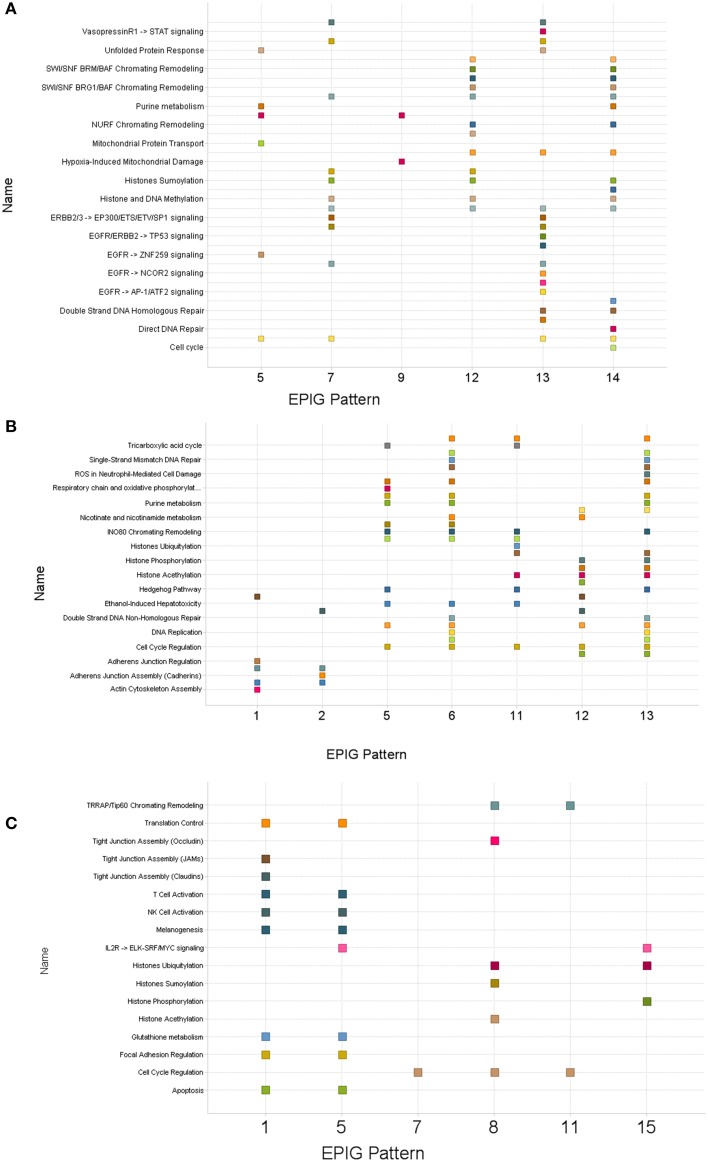
Scatter plots of pathways enriched in patterns derived from bone marrow collected post-treatment with topotecan, oxaliplatin, or a combination. Clusters of genes identified by EPIG were then analyzed using Gene Set Enrichment Analysis (GSEA) and Sub-Network Enrichment Analysis (SNEA) algorithms to find enriched pathways. (A) One hour post-treatment. (B) Six hours post-treatment. (C) Twenty-four hours post-treatment. The numbers on the x-axis denote the EPIG pattern which contained the genes that enriched the pathways labeled on the y-axis. A square represents a pathway that was enriched by the genes in the given EPIG pattern.